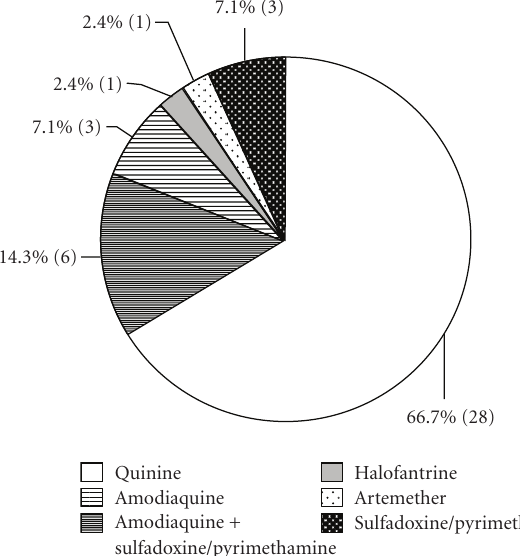
Figure 2: Types of prescription of antimalarial drugs in